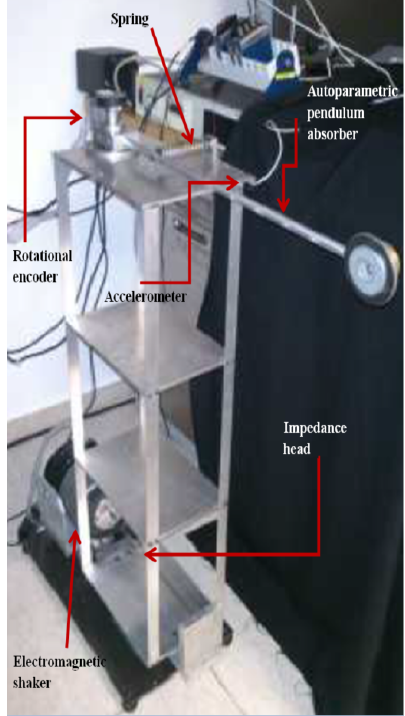
Figure 10. Experimental setup of the main system with an autoparametric pendulum